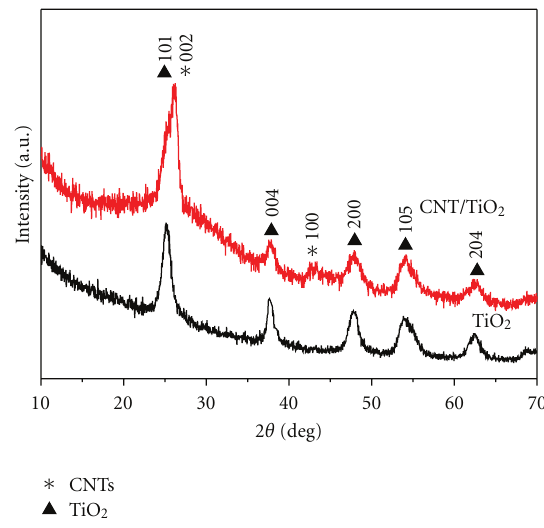
Figure 1: XRD patterns of the as-prepared CNT/TiO 2 nanohybrids and TiO 2